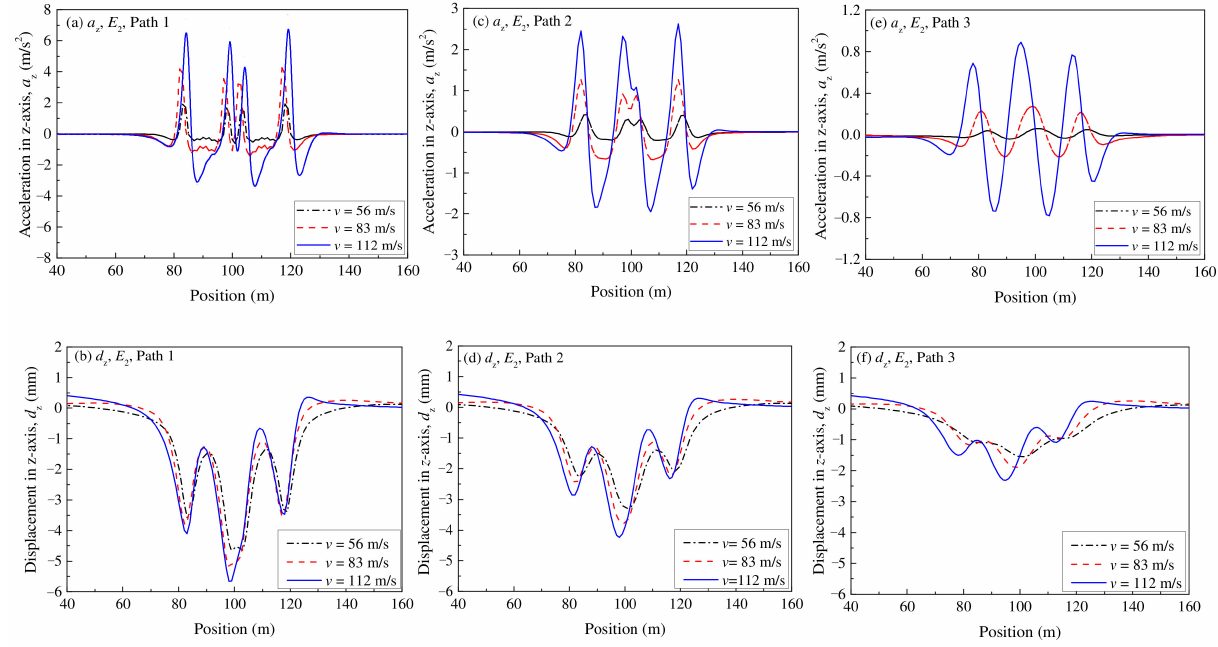
Figure 11. Comparisons of a z , d z with different speeds in different paths: ( a ) a z in Path 1; ( b ) d z in Path 1; ( c ) a z in Path 2; ( d ) d z in Path 2; ( e ) a z in Path 3; ( f ) d z in Path